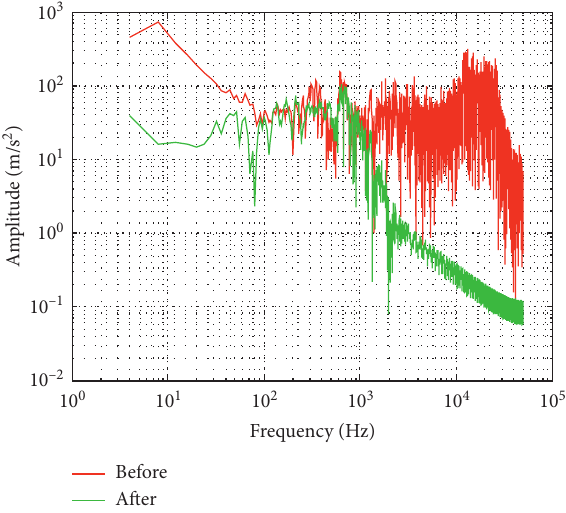
Figure 12: Fourier spectrum comparison of signal before and after preprocessing.